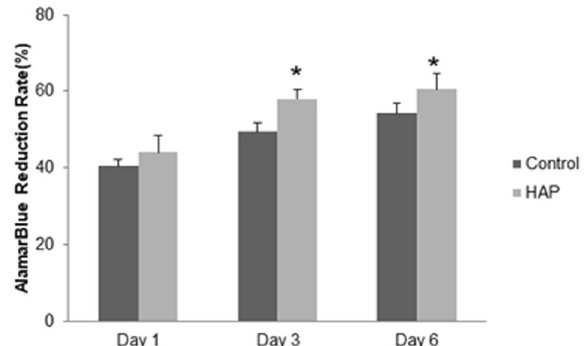
Fig. 1 Alamar Blue reduction rate after 1, 3 and 6 days of MC3T3-E1 cell culture with standard (control) or HAP preconditioned medium. * p < 0.05 vs. control group (One-way ANOVA with Tukey ’ s test)